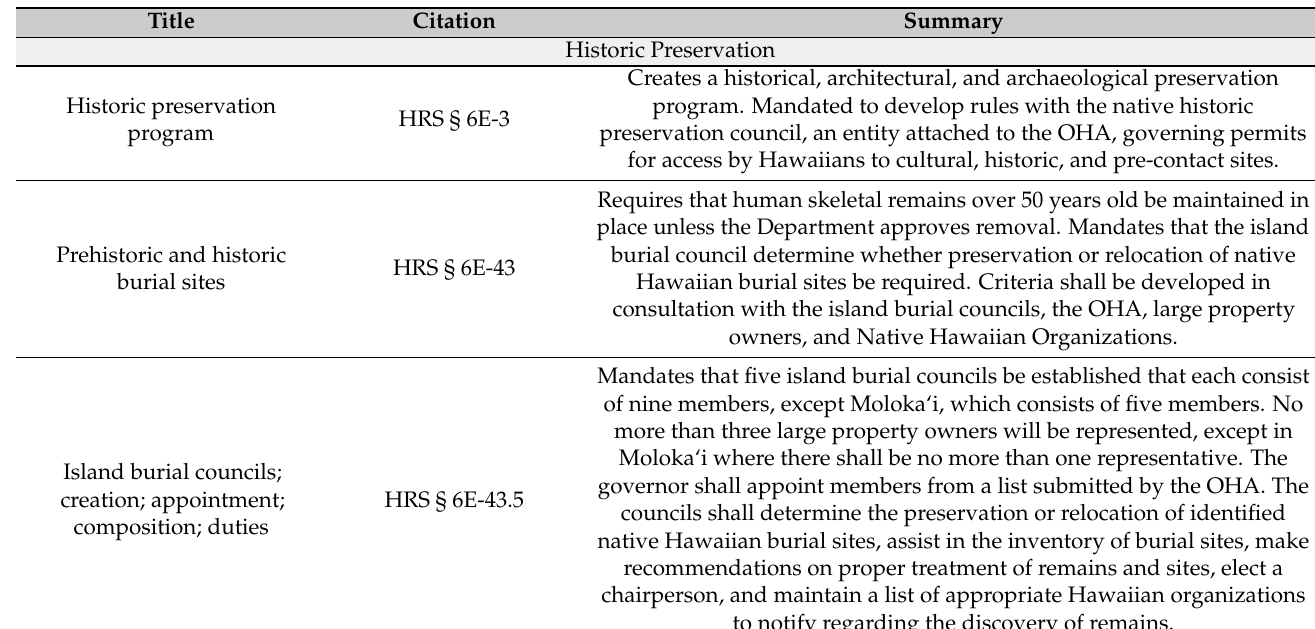
Table 1. Summary of